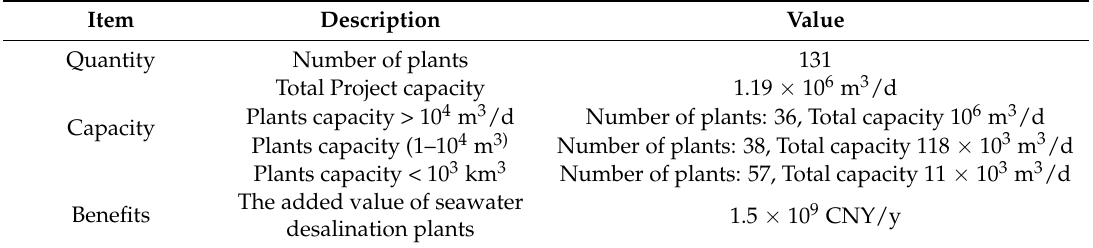
Table 1. Water desalination projects development in China until 2016 (Based on